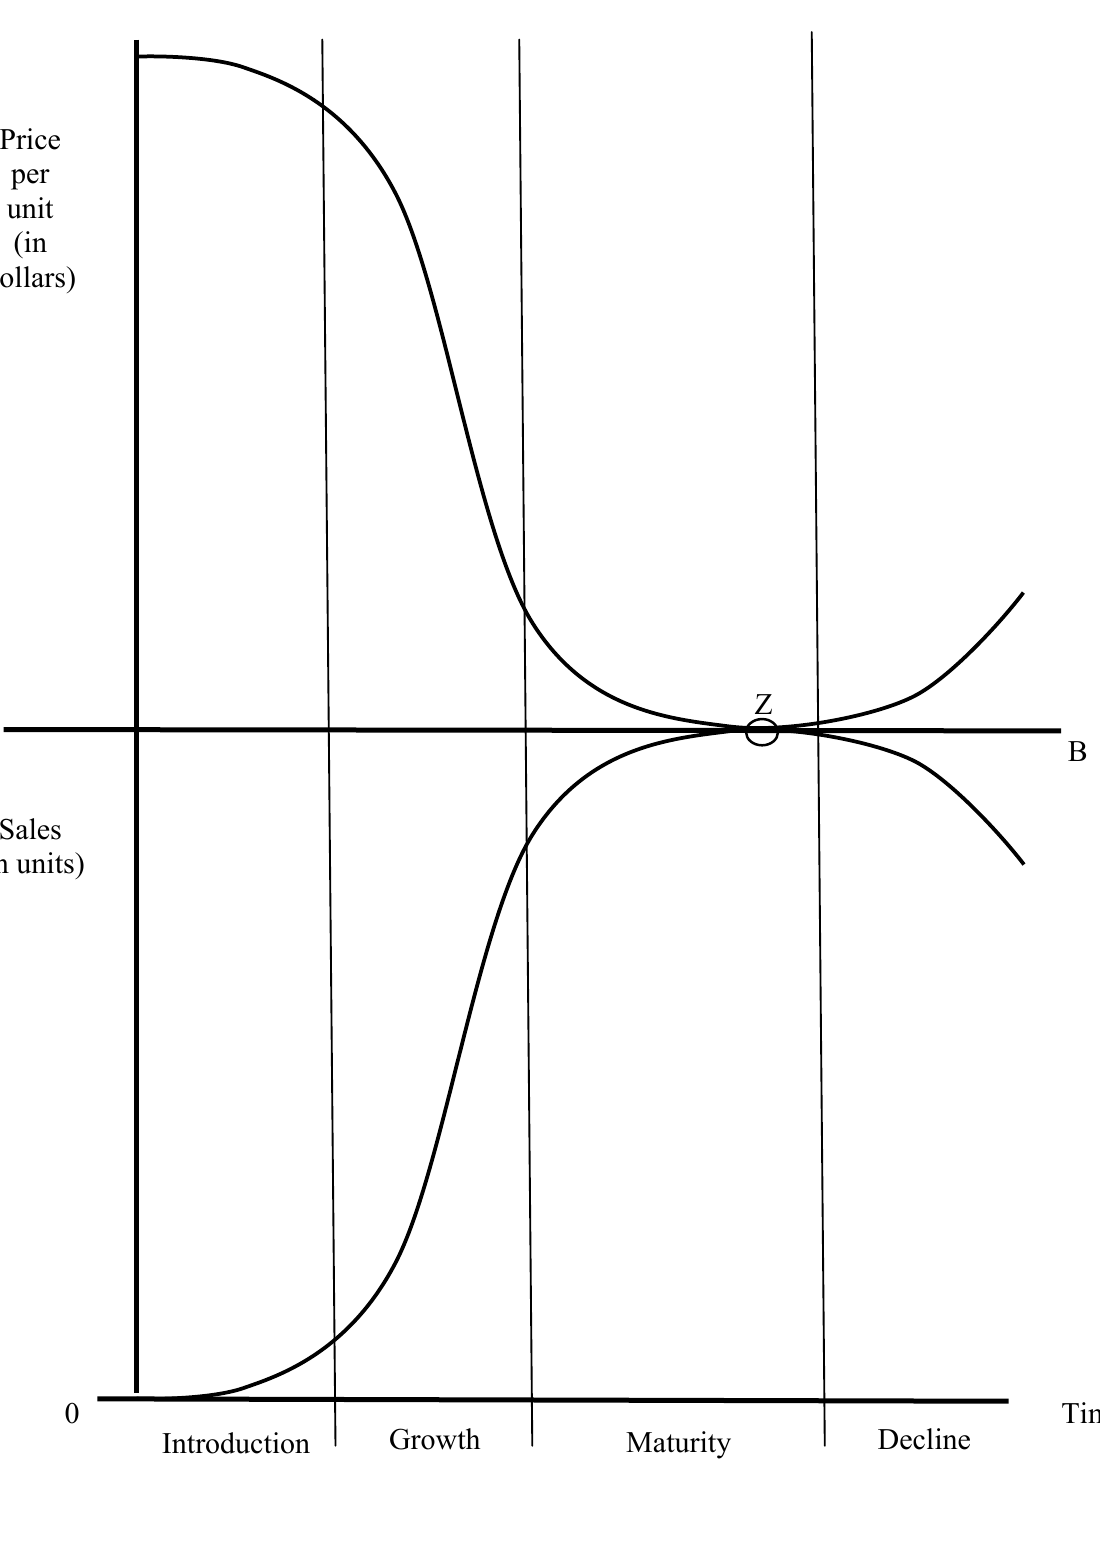
Fig. 2. Modified product life